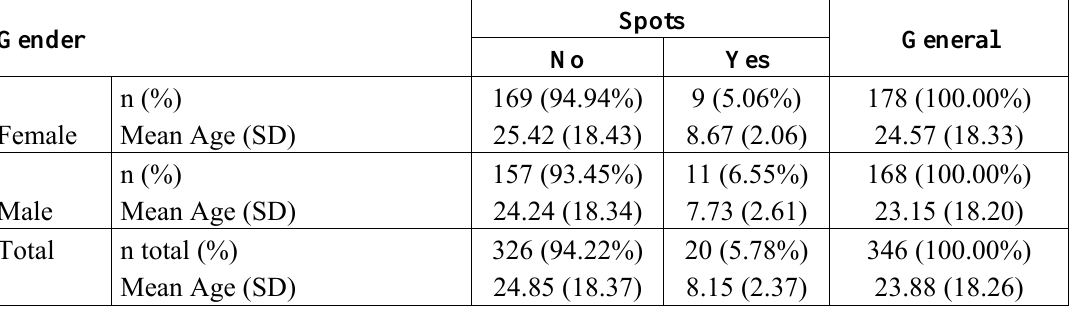
Table 2. Number of subjects, mean age and standard deviation according to gender and according to the presence or absence of spots, Caapiranga, AM, Brazil, 2011.